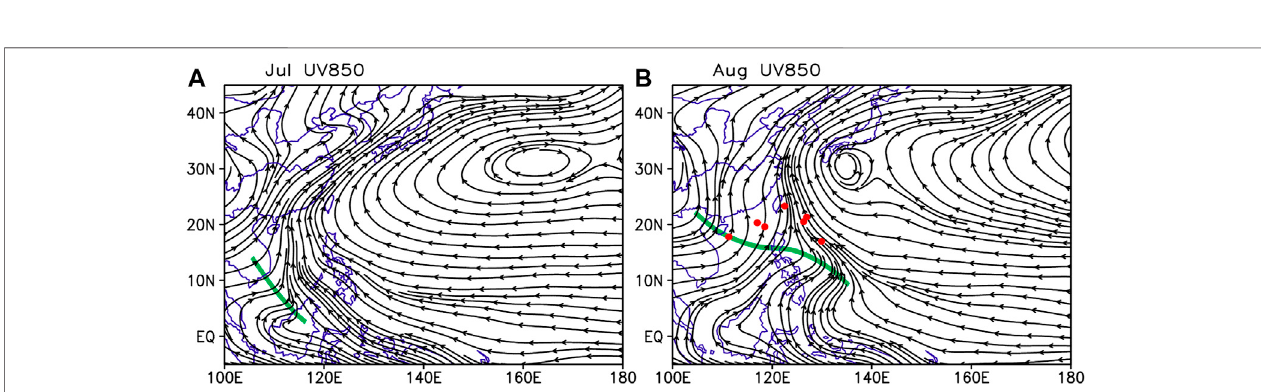
FIGURE 6 | Distribution of streamline at 850hPa in (A) July and (B) August 2020. The bold green lines indicate the monsoon trough location. The red dots in (B) indicate the locations of TC geneses.